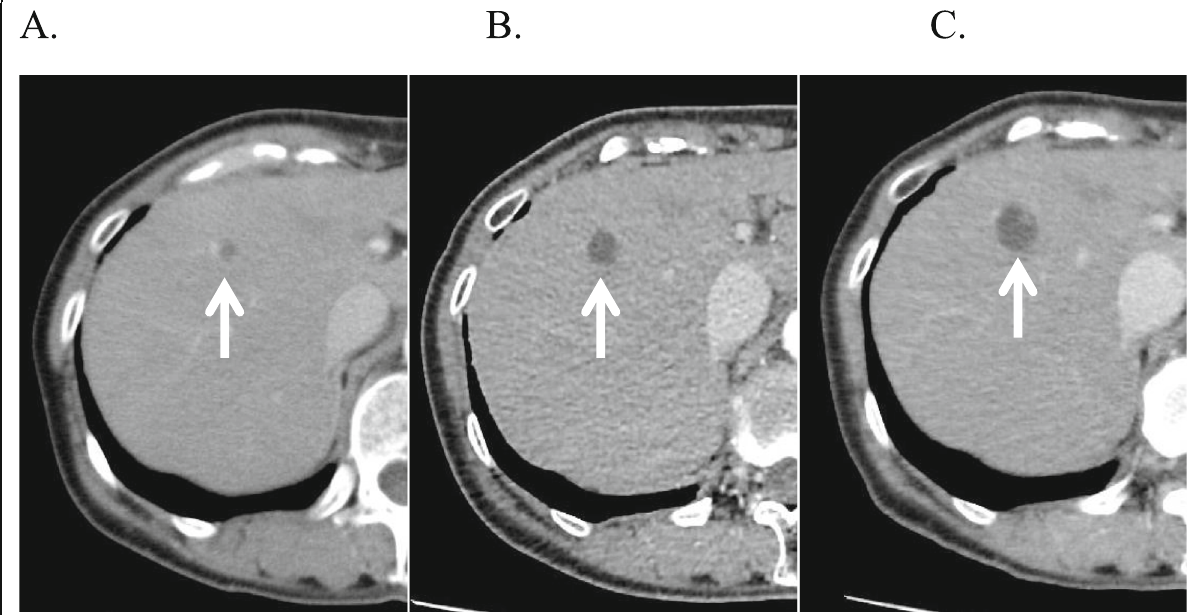
Fig. 1 Computed tomography findings. Computed tomography scans showed a a 7-mm cystic nodule in 2012 (white arrow), b an 11-mm cystic nodule in 2016 (white arrow), and c a 17-mm cystic nodule in 2017 (white arrow) as well as a mural nodule in the